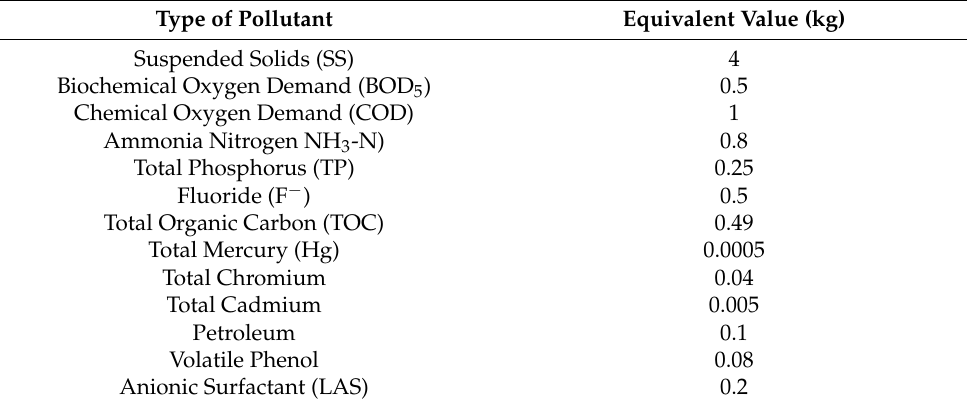
Table 1. Pollutant equivalent value in the environmental protection tax law of